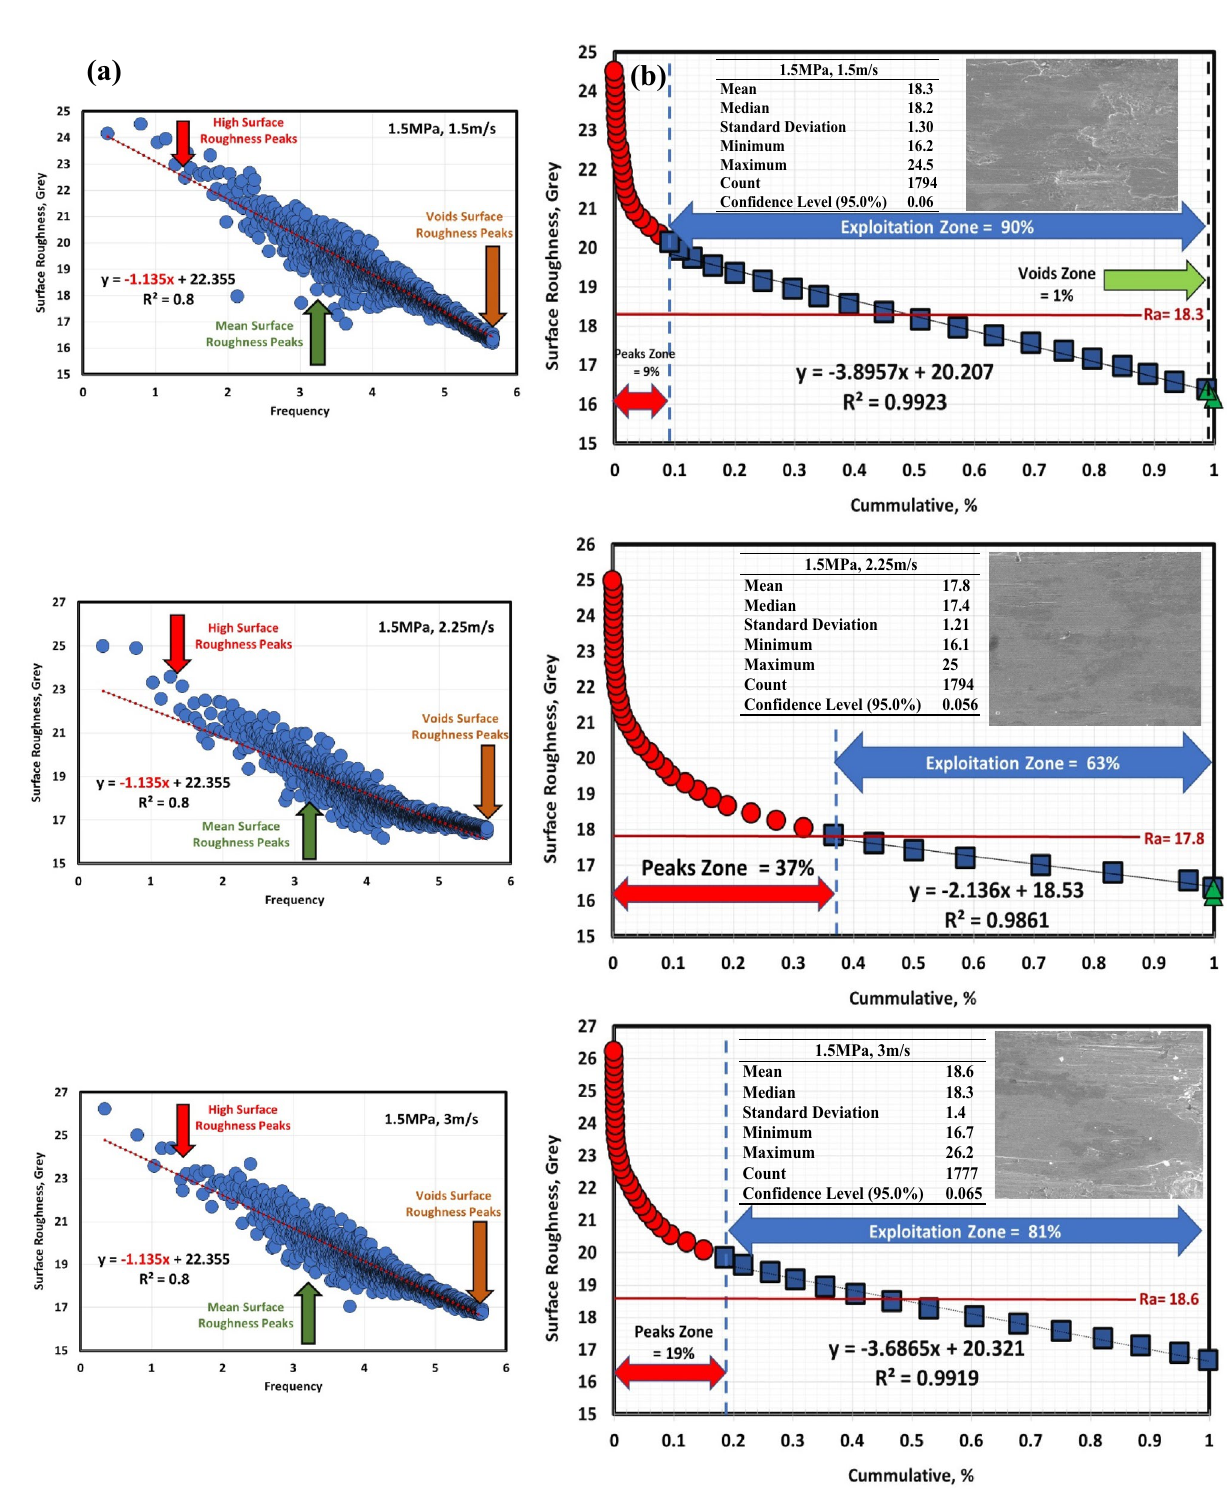
Figure 10. ( a ) Surface texture and ( b ) Abbott Firestone curves at 1.5 MPa and different velocities of QAM f